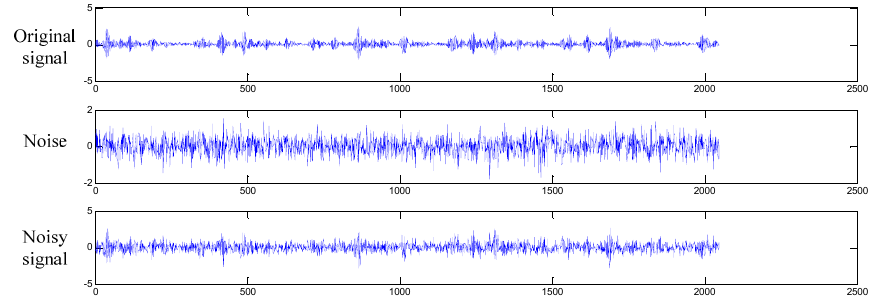
Figure 11. Figures for original signal of inner race fault, the additive white Gaussian noise, and the composite noisy signal with SNR = 0 dB respectively. Table 4. Results for WDCNN under different noisy environment.